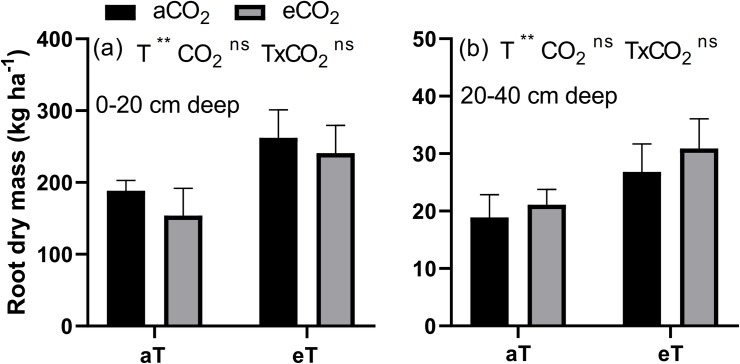
Root dry mass at 0–20 cm deep (A) and at 20–40 cm deep (B) of P. maximum at 30 days after treatments. Treatments: aTaCO2 (ambient temperature and ambient [CO2]), eTaCO2 (2°C above ambient temperature and ambient [CO2]), aTeCO2 (ambient temperature and 200 ppm above ambient [CO2]), and eTeCO2 (2°C above ambient temperature and 200 ppm above ambient [CO2]). Bars show means and SE of four replicates. ns and **: not significant and significant at 1%, respectively.